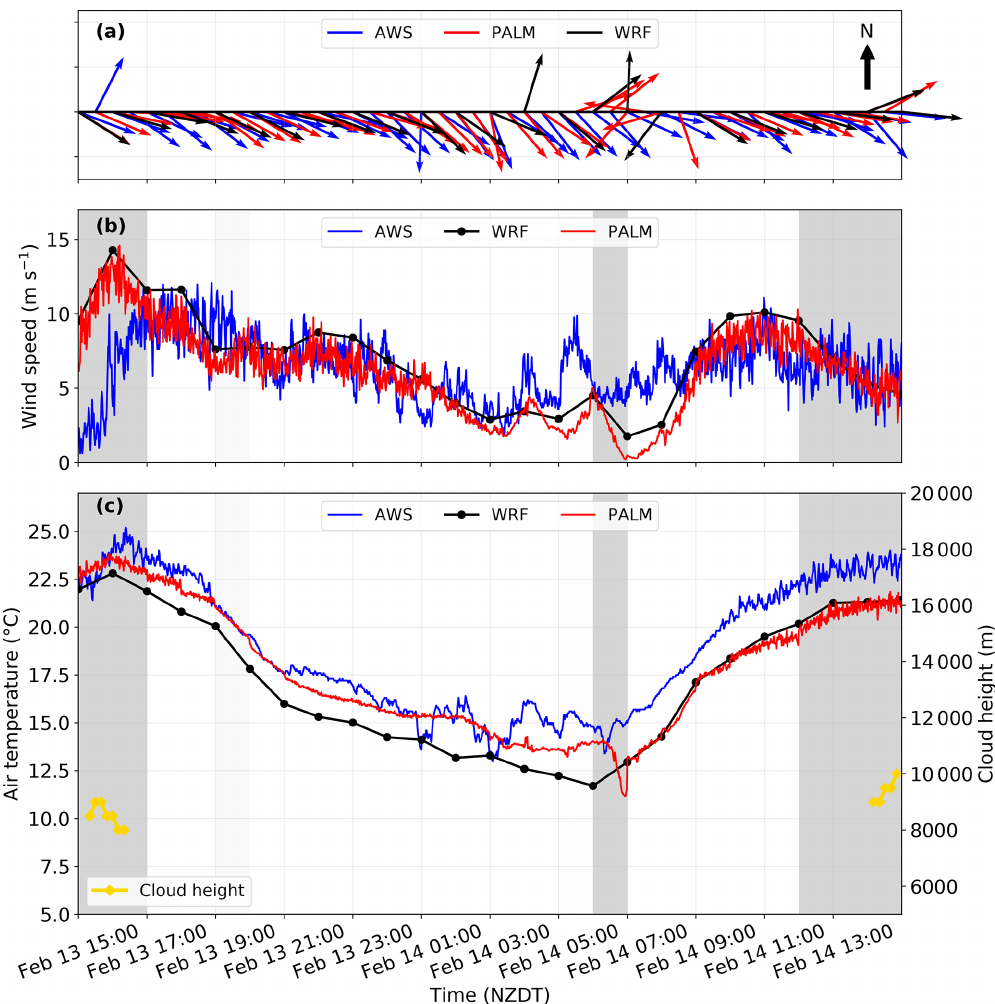
Figure 4. The time series of simulated (a) wind direction, (b) wind speed, and (c) air temperature for the north-westerly case between 15:00NZDT, 13 February and 15:00NZDT, 14 February 2017 compared with observations (labelled as AWS). In panel (c) the yellow line indicates cloud height observed at the AWS. In panels (b) and (c) , the shaded grey periods indicate when clouds are simulated in the WRF model. Only 30min PALM and observational data for wind direction are shown in (a) to avoid overlapping of arrows.